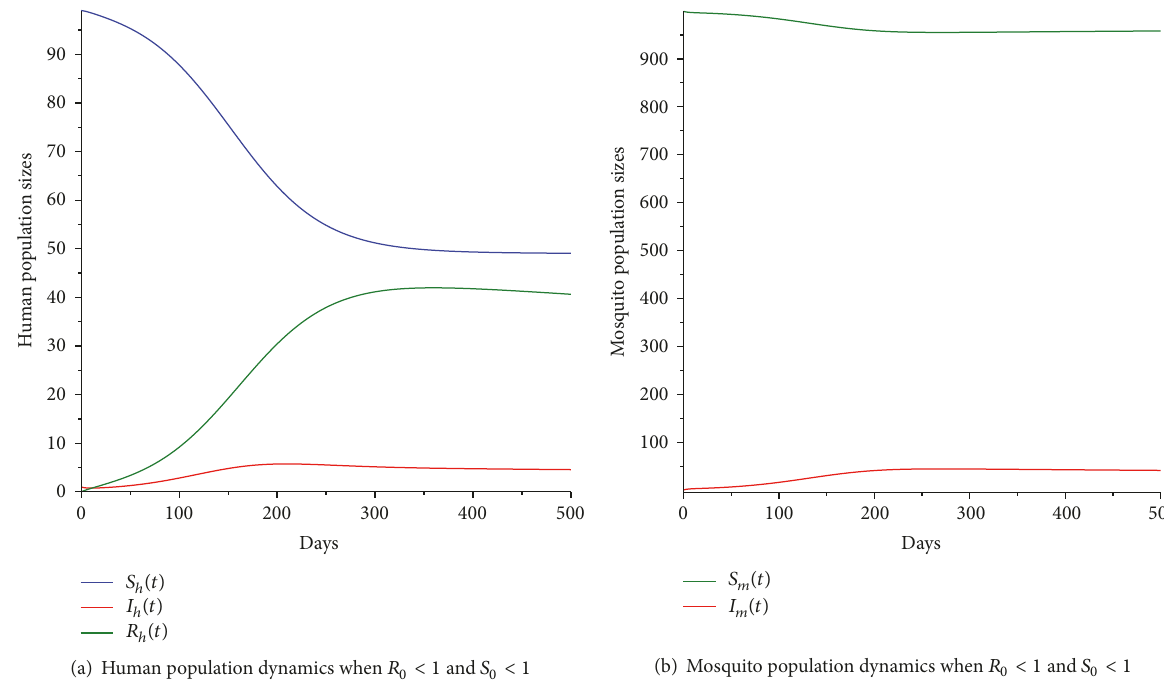
Figure 5: Malaria dynamics when 𝑅 0 = 0.4564 and 𝑆 0 = 0.5661 and 𝑃 0 = 0.9476 .